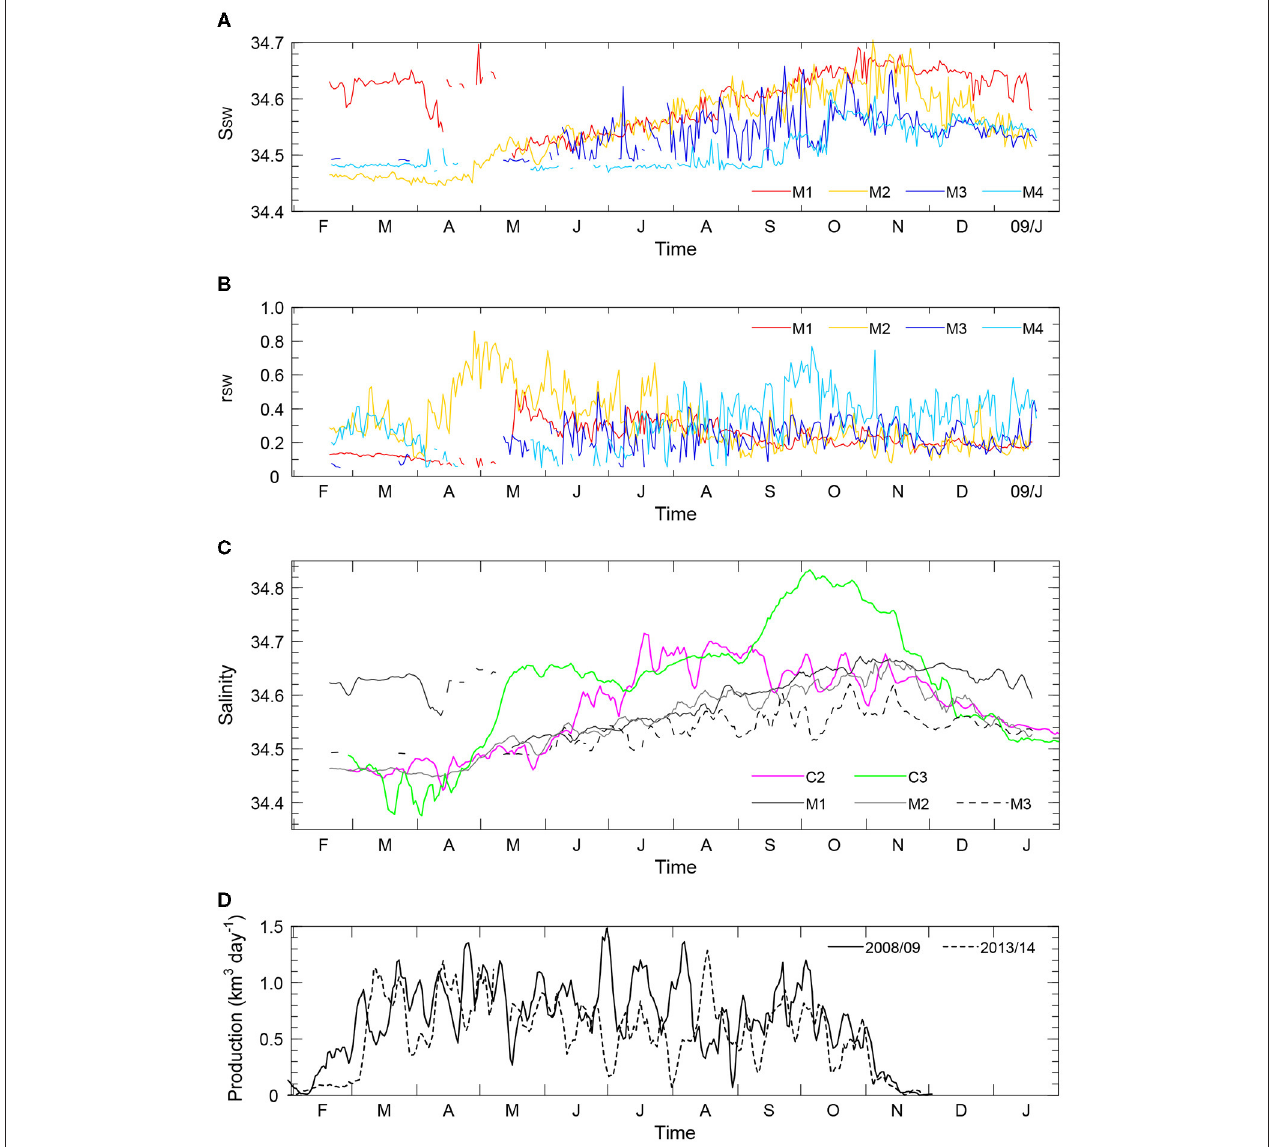
FIGURE 10 | (A,B) Time series of (A) S SW and (B) r SW for the deepest CT sensors at moorings M1 (red), M2 (orange), M3 (blue), and M4 (light blue). (C) Time series of salinity at moorings C2 (magenta) and C3 (green). The solid, gray, and dashed lines in (C) indicate S SW at moorings M1, M2, and M3, respectively. (D) Time series of sea-ice production in the Cape Darnley polynya in 2008–2009 (solid line) and 2013–2014 (dashed line). A 5 day running mean is taken for data in (C,D) . The lines are not drawn for S SW and r SW in the period of r SW < 0.05 in (A–C) .